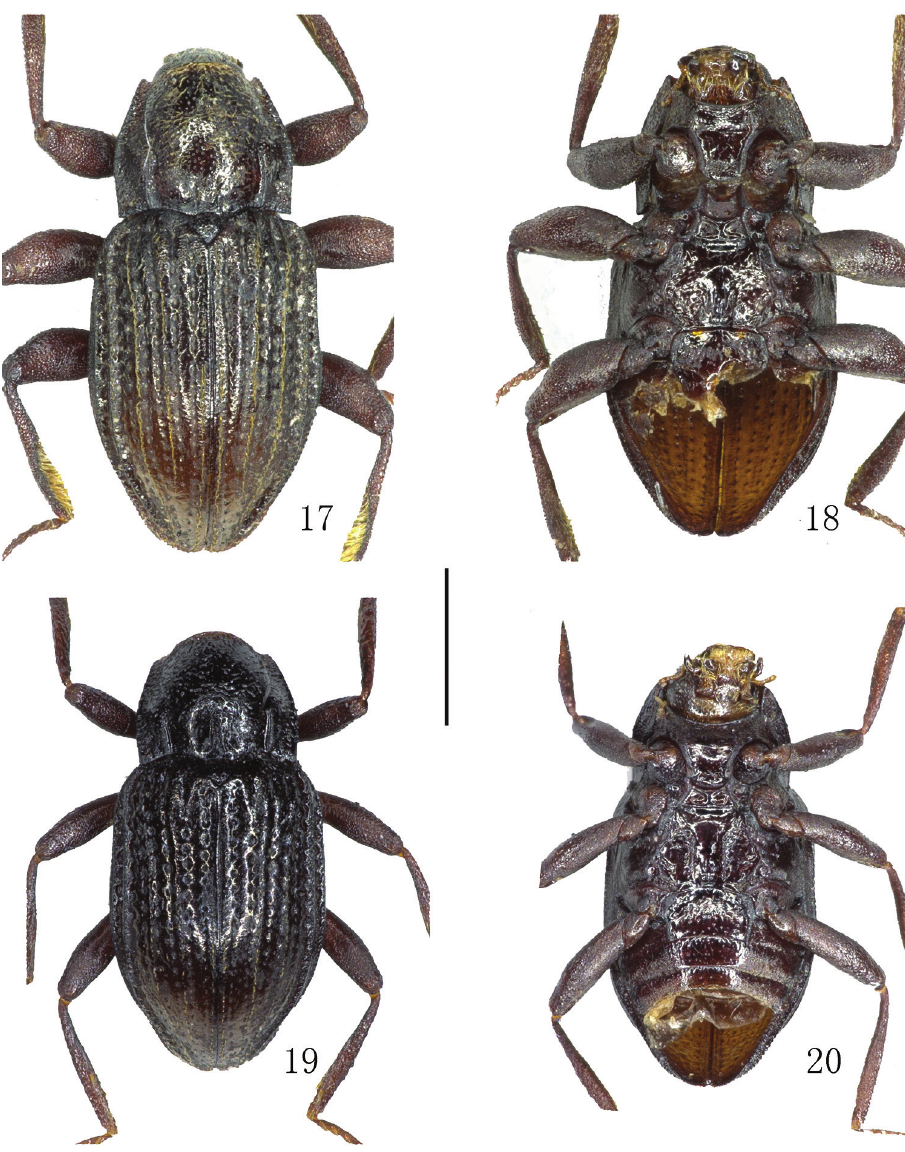
Material examined. Paralectotypes: 1male, 1 female: “Yun-nan, Chine / Grou- velle / 1906” (white label); “PARALECTOTYPUS / Microdes / sinensis Grouvelle / des. M. A. Jäch” (red